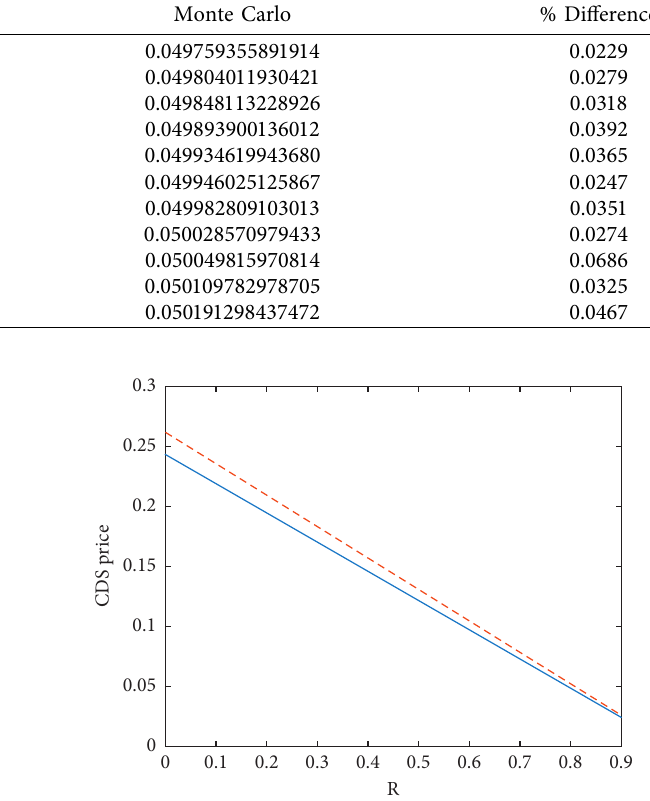
Figure 1: The CDS prices under different number of assets.